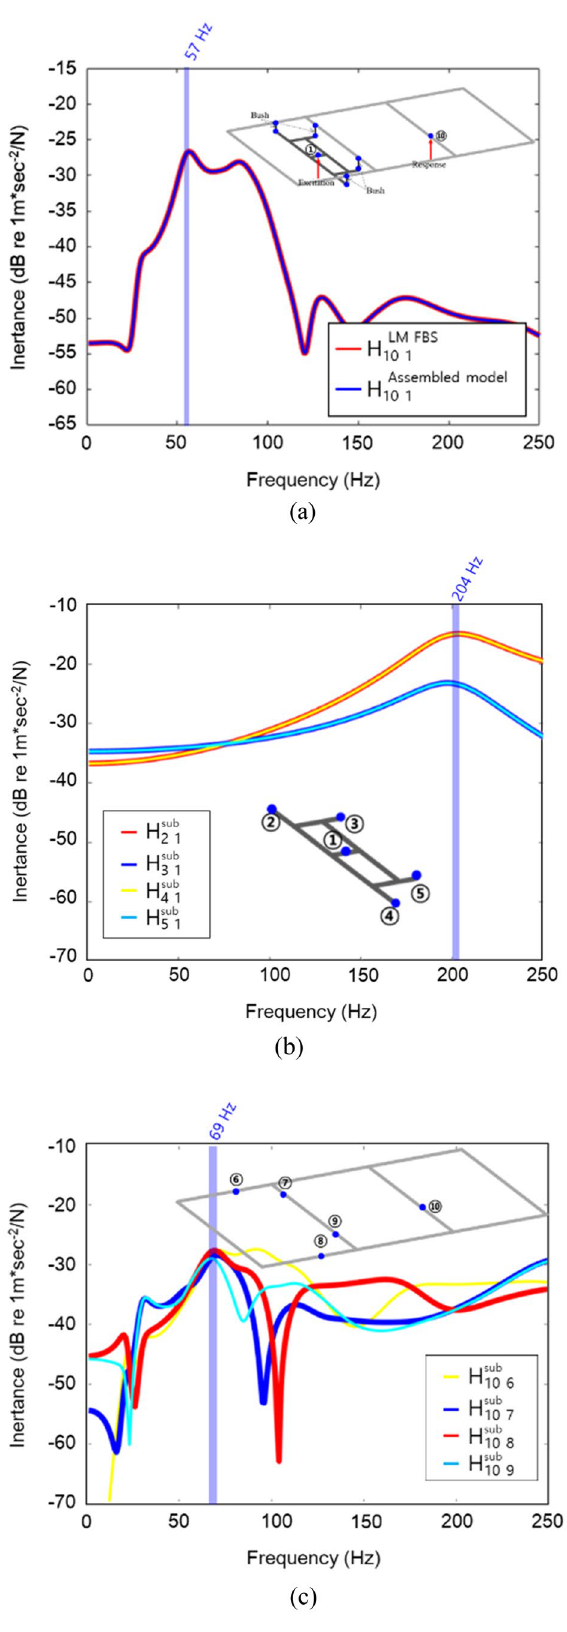
Figure 3. Frequency response functions. ( a ) The simplified structure; ( b ) Subframe; ( c )